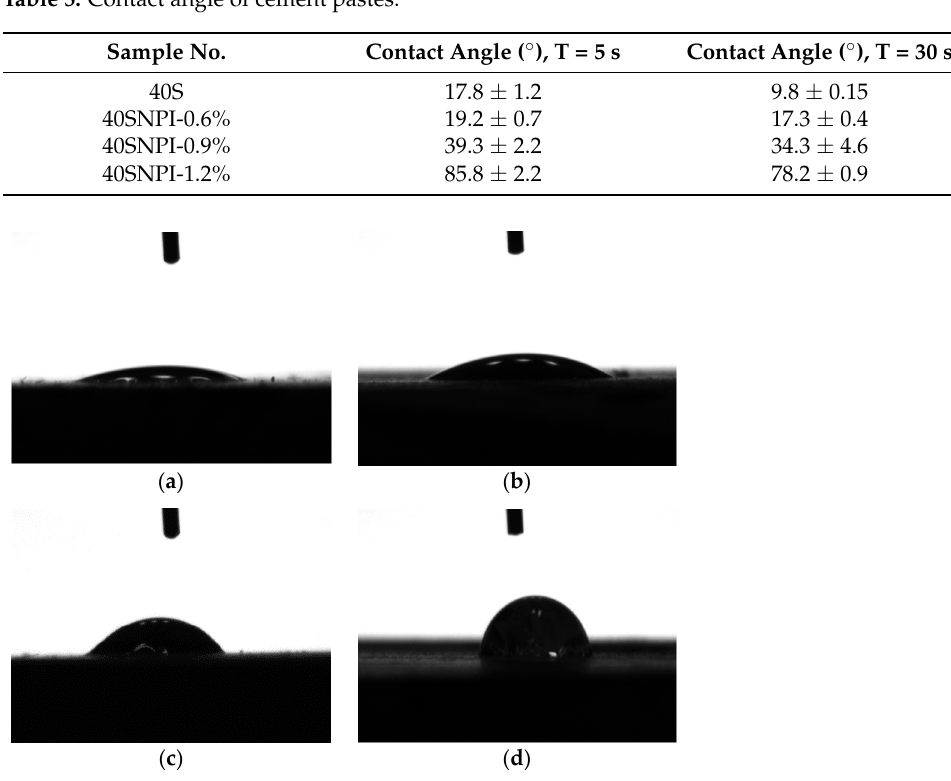
Table 4. The total porosity and the mean pore size of cement pastes calculated by MIP.